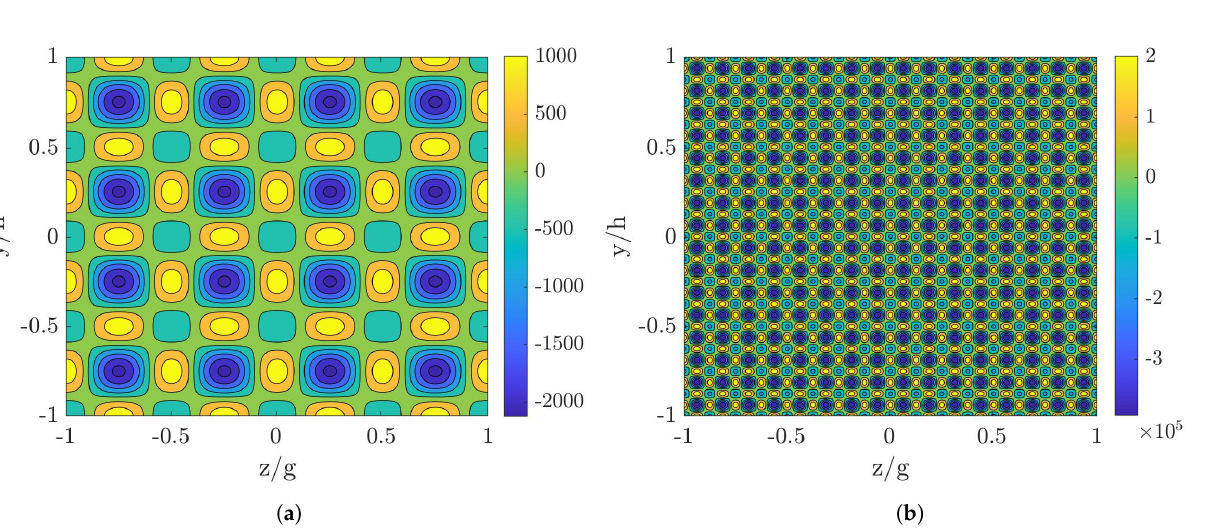
Figure 2. Function F test for ( a ) m , n = 4 and ( b ) m , n = 16. In both cases, α =